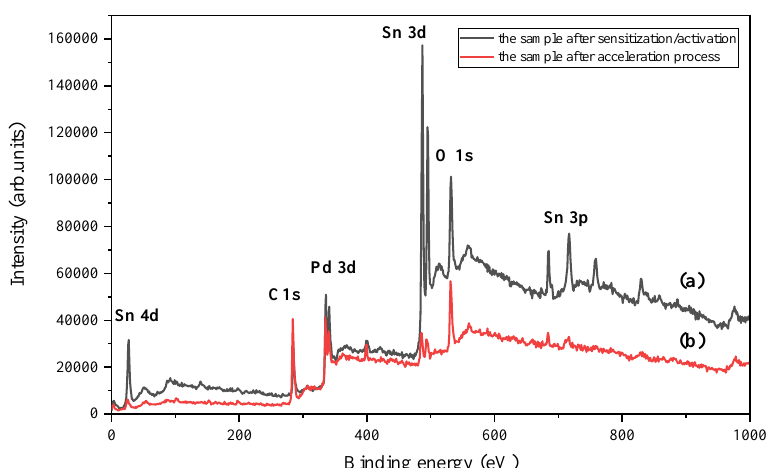
Figure 9. XPS spectra of top-surface of the sample after sensitization/activation process (a) and after acceleration process (b).